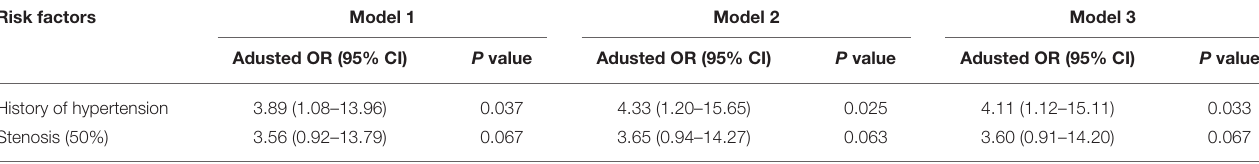
TABLE 3 | Factors independently associated with T max ≥ 4s ≥ 10 ml in patients after TIA.